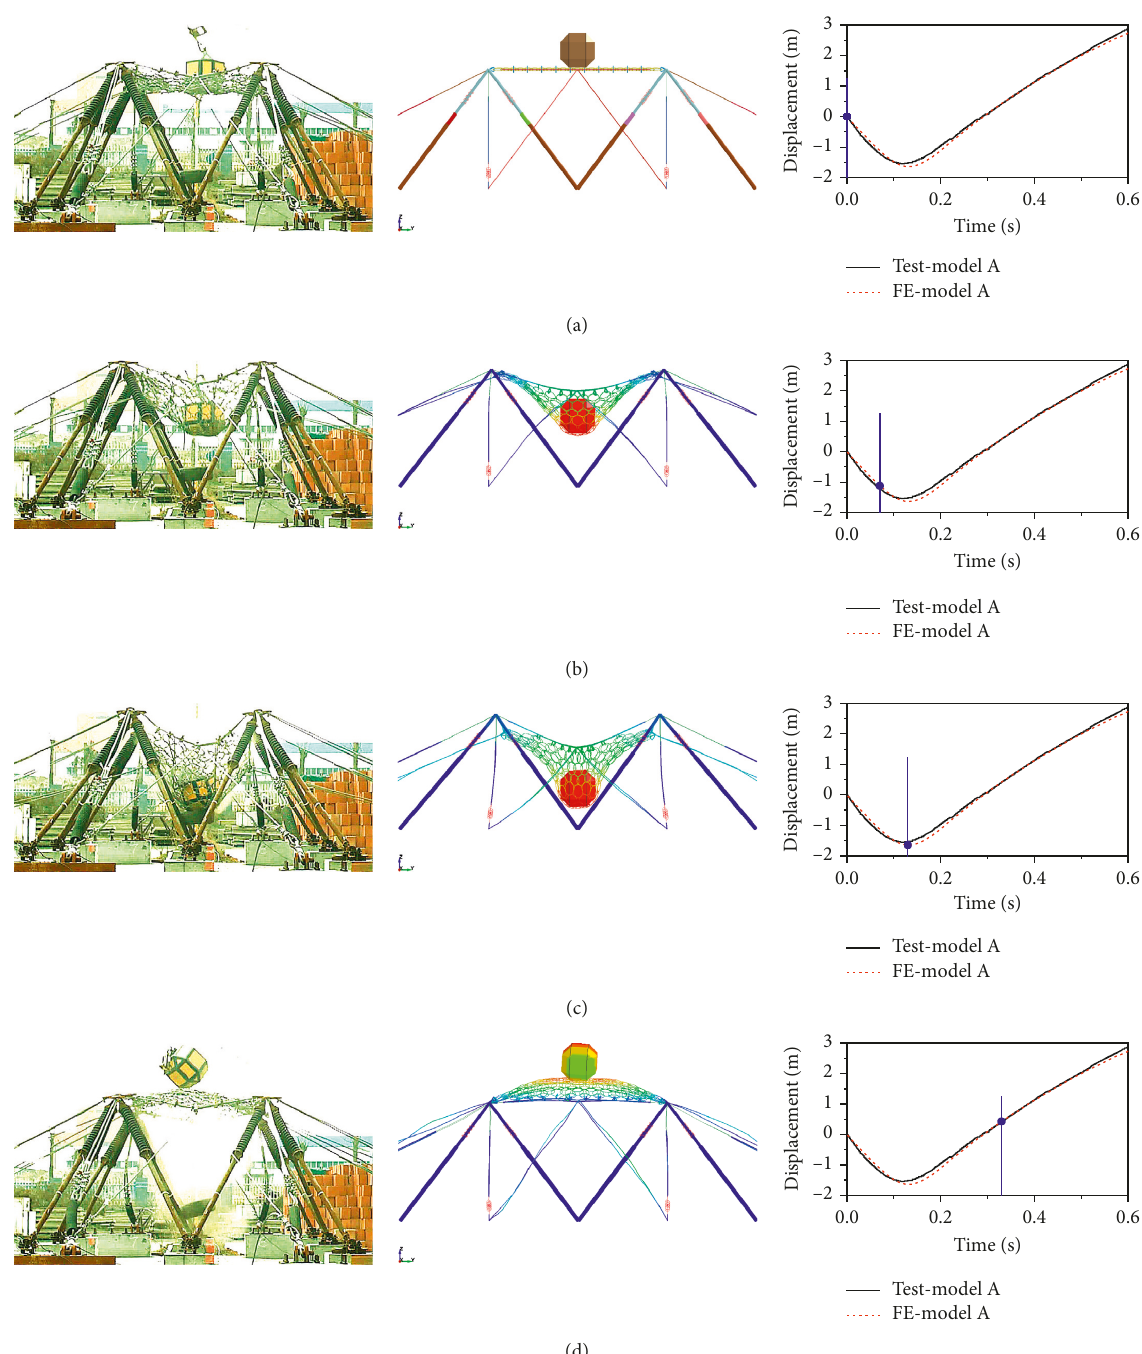
Figure 14: Deformations at several typical moments. (a) The block contacts the ring nets ( t � 0s). (b) Compression of the spring rods ( t � 0.07s). (c) Position of maximum impact displacement ( t � 0.13s). (d) Block rebounds out of the ring nets ( t � 0.33